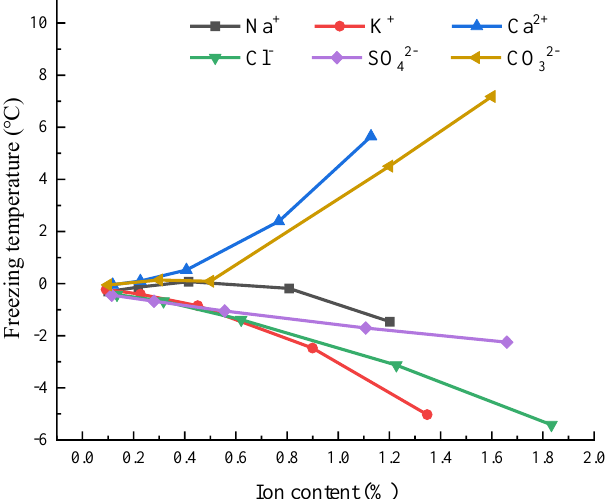
Figure 8. The relationship between freezing temperature and the content of each ion under 30% water